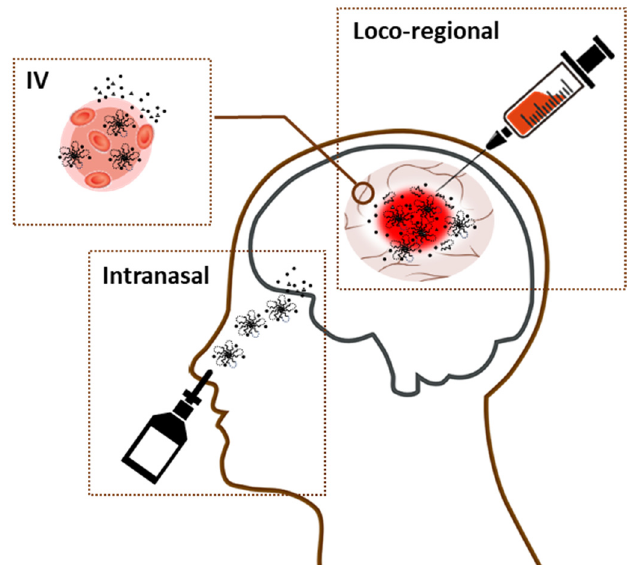
Figure 2. Administrations of nanogels that target brain. McCrorie et al. designed a spray delivery system consisting of a bioadhesive hydrogel (pectin) and poly(ethylene glycol)-block-polylactic acid (PEG-b-PLA) micelles carrying burst release of 5% for olaparib in the first 30 min followed by 85% after 24 h. For